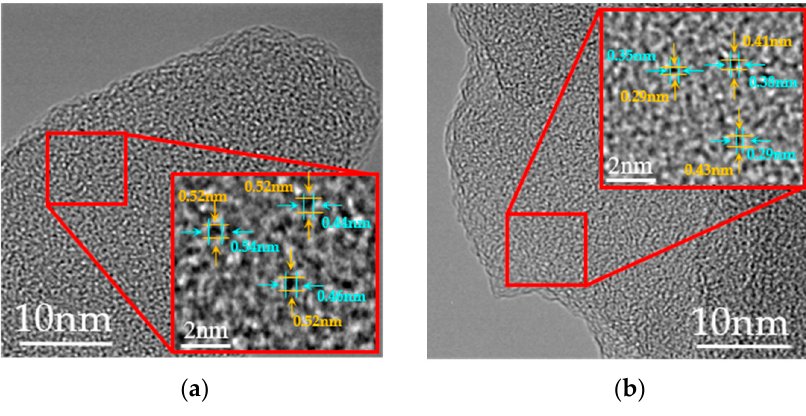
Figure 7. TEM images of CLA-PAN-230 ( a ) and CLA-PAN-260 ( b ) membranes.